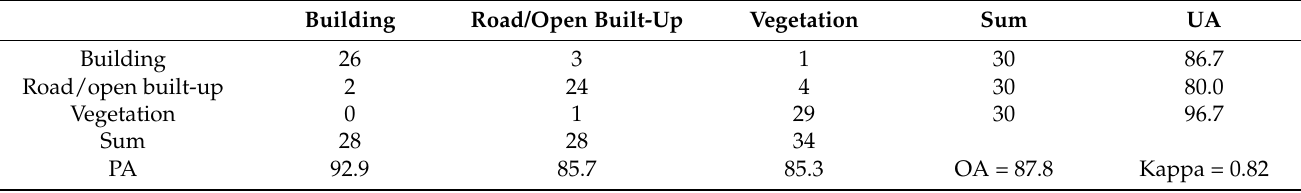
selected for the accuracy assessment. UA and PA denote user’s and producer’s accuracy,